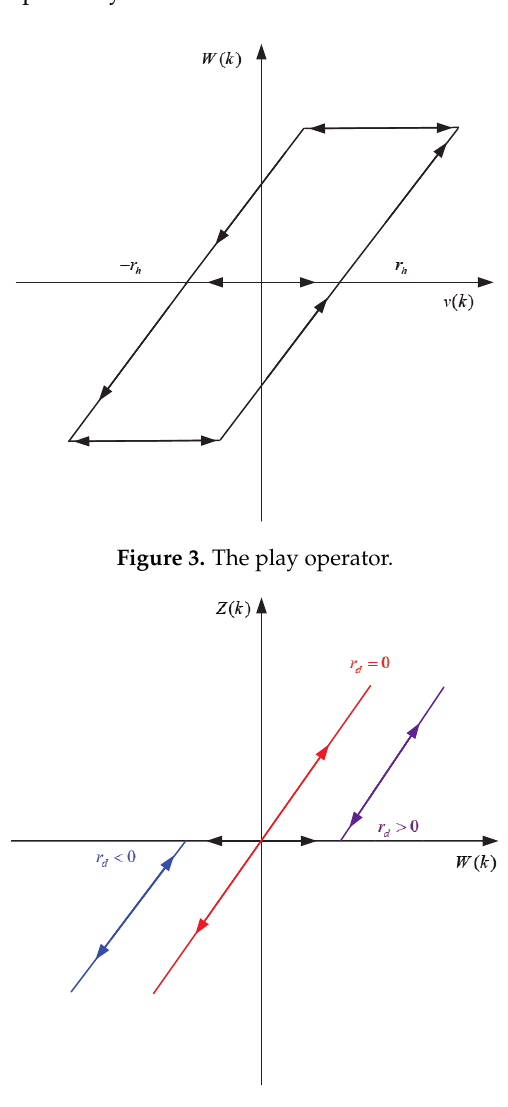
Figure 4. The one side dead-zone